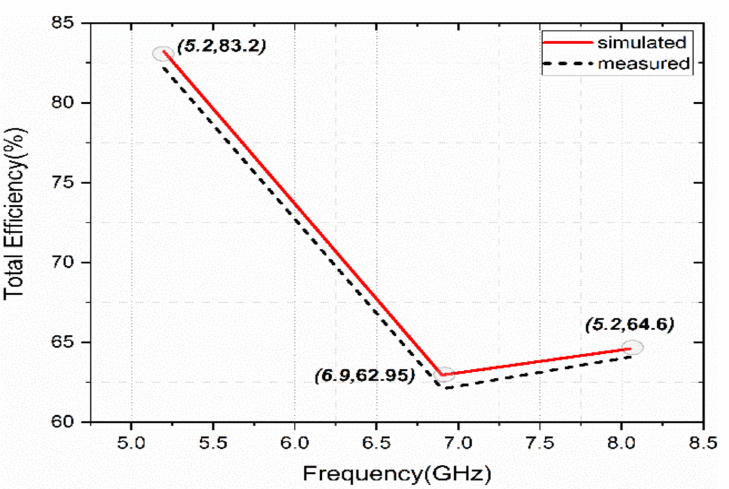
Figure 15. Total efficiency as a function of